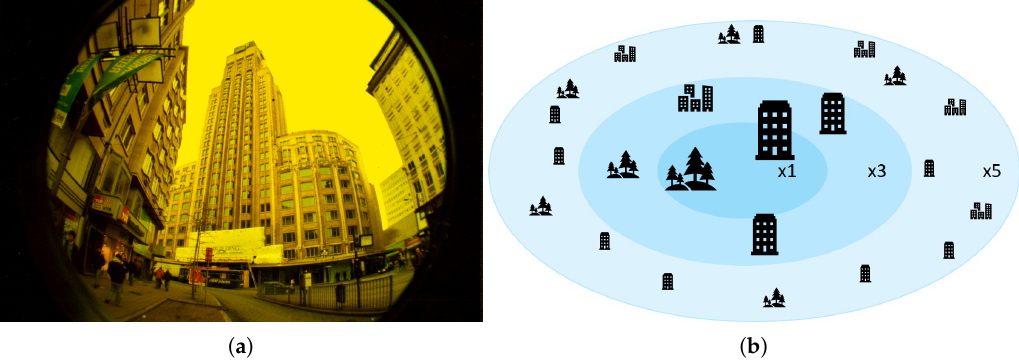
Figure 6. Concept of Fisheye HVIN: ( a ) fisheye view [42]; and ( b ) fisheye diagram.